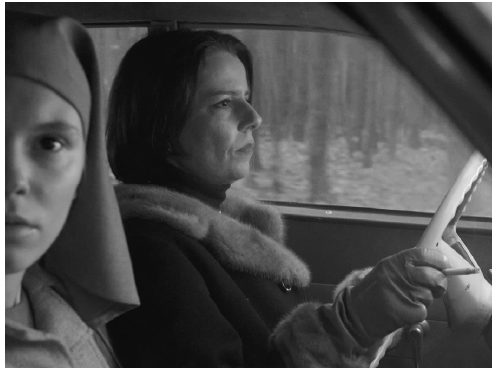
Figure 12. Ida in an unbalanced frame. Figure 13. Ida’s face falls off frame. Figure 13. Ida’s face falls off